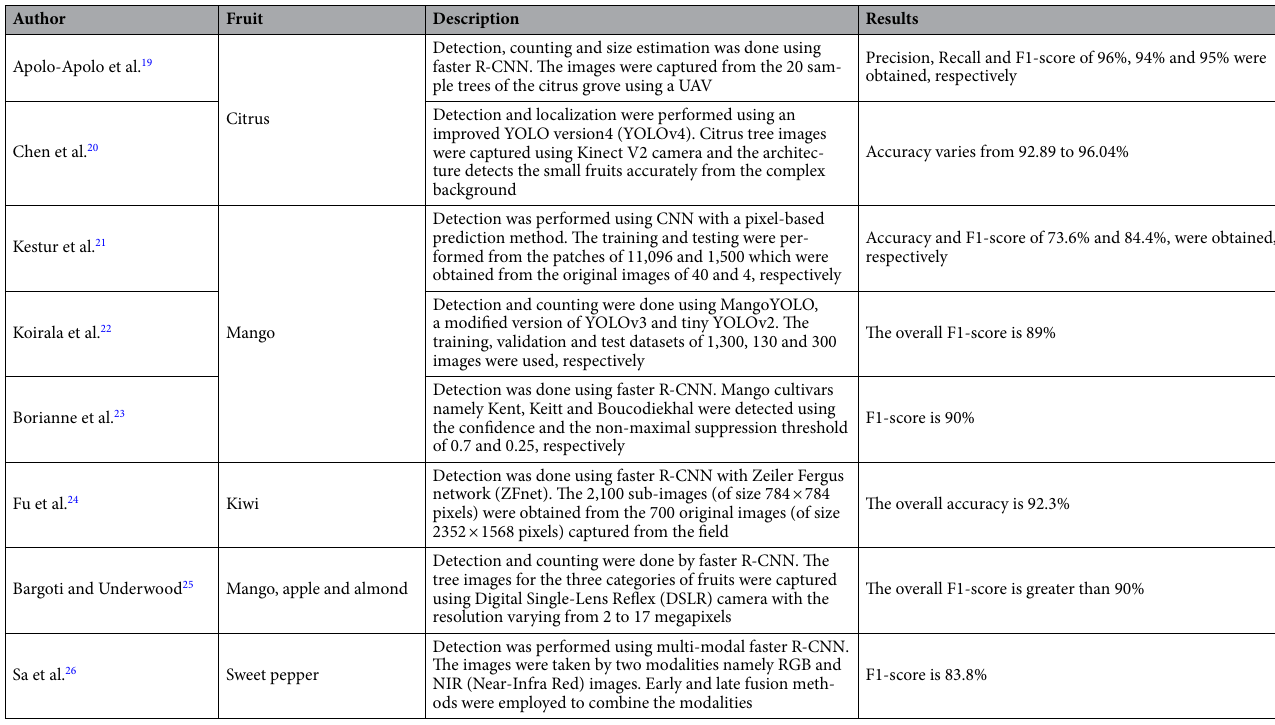
Table 1. Literature related to various fruit YE using DL-based semantic